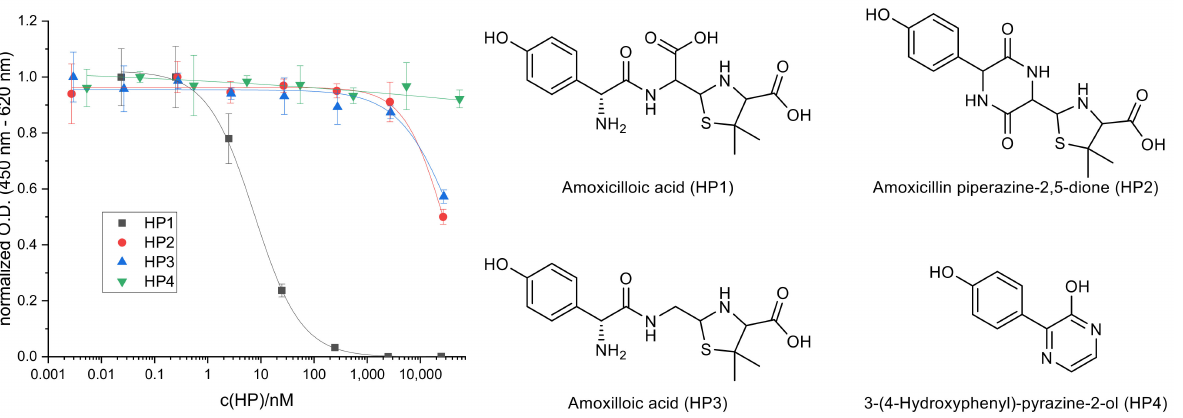
Figure 3. ELISA calibration curves of selected AMX hydrolysis products and their